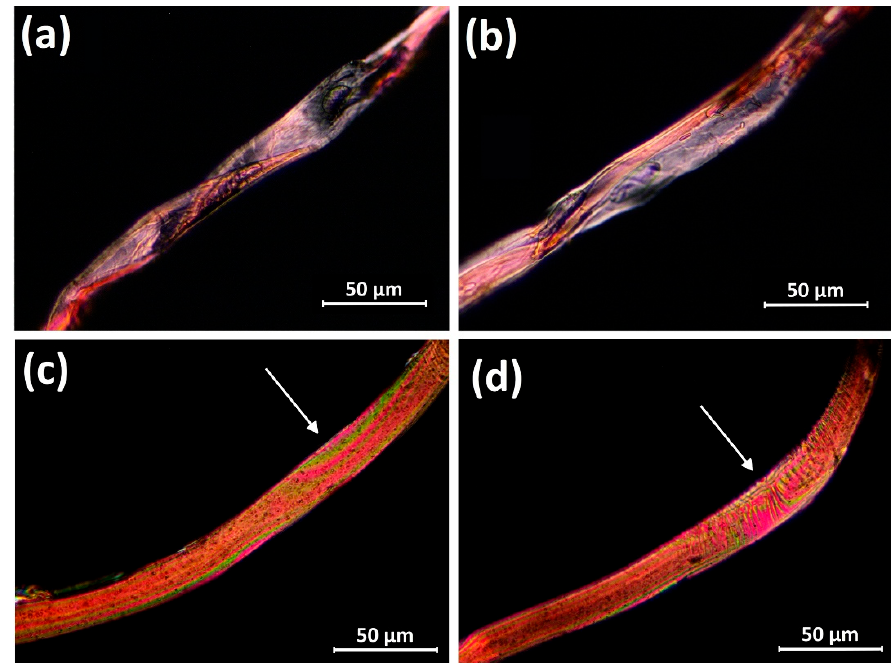
Figure 5. Polarised light microscopy images of cotton fibre of Sample 2 (CO 79/PES 21) and polyester fibre of Sample 4 (CO 70/PES 30): Cotton fibre ( a ) before exposure and ( b ) after radiant heat exposure (10 kW·m − 2 , 40 s); polyester fibre ( c ) before exposure and ( d ) after radiant heat exposure (10 kW·m − 2 , 40 s).